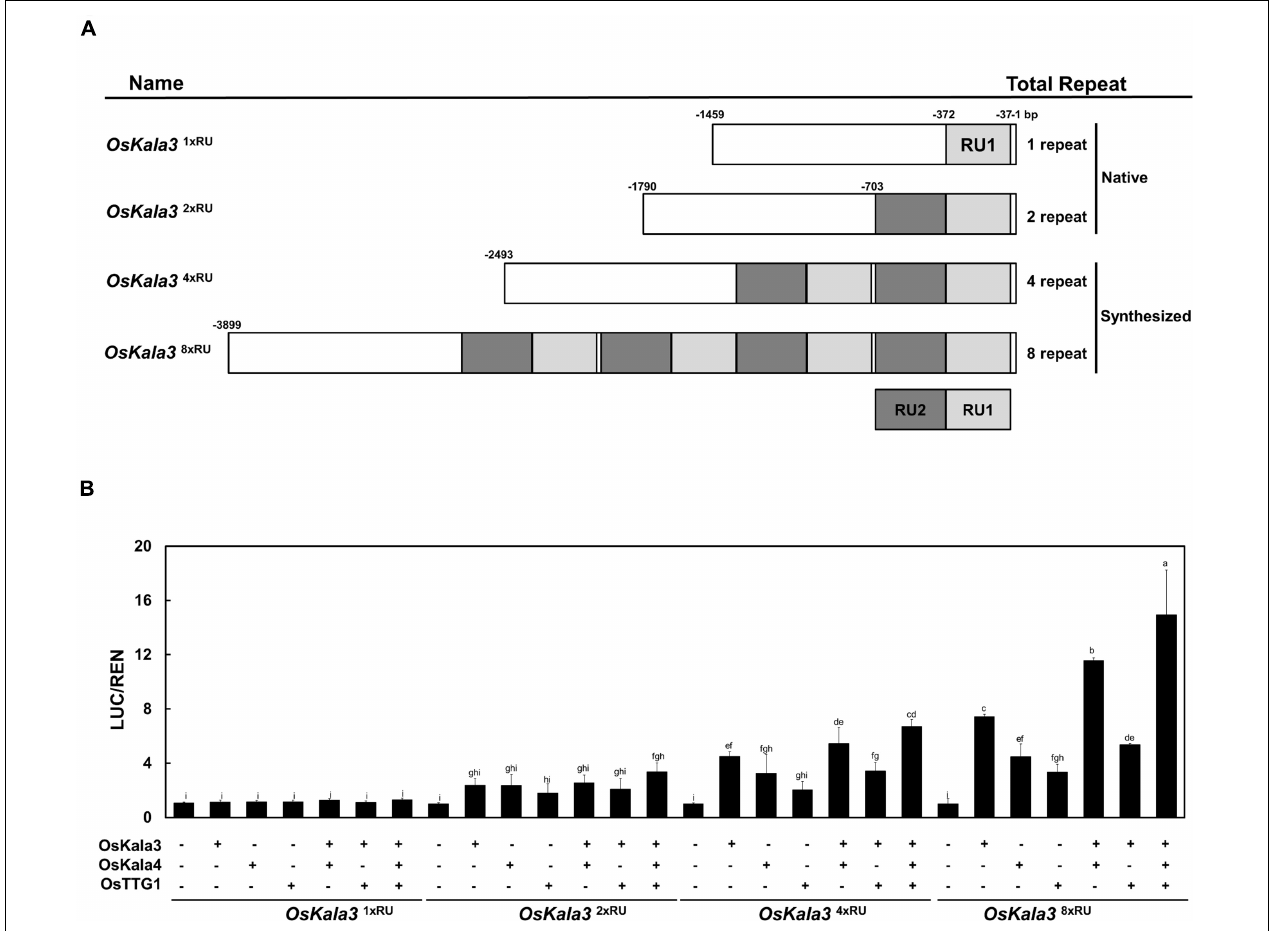
FIGURE 6 | The number of repeat units in the OsKala3 promoter region affects its transactivation rate. (A) Schematic representation of the promoter constructs used in the assay, bearing one, two, four, or eight repeat units (RU). The IM cultivar carries one RU copy in the OsKala3 promoter, while the cultivar HJJ carries two copies of the element. RUs are indicated in light and dark gray. (B) Increasing the number of RU copies raises the activation of OsKala3 transcription when co-transformed with 35S:OsKala3 , 35S:OsKala4 , and 35S:OsTTG1 . Results represent mean values ± SD from three independent biological replicates. The fLUC/rLUC ratio in the absence of effectors was set to